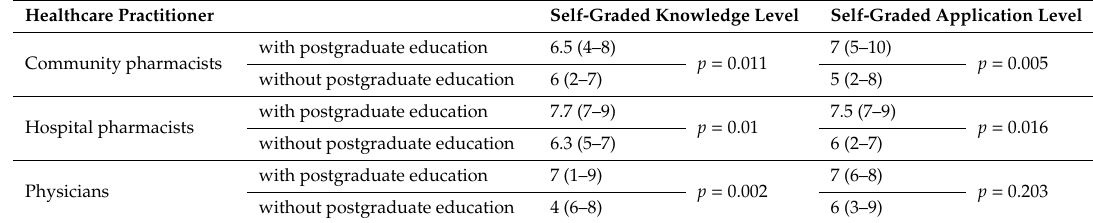
Table 1. Self-graded knowledge and application level of healthcare